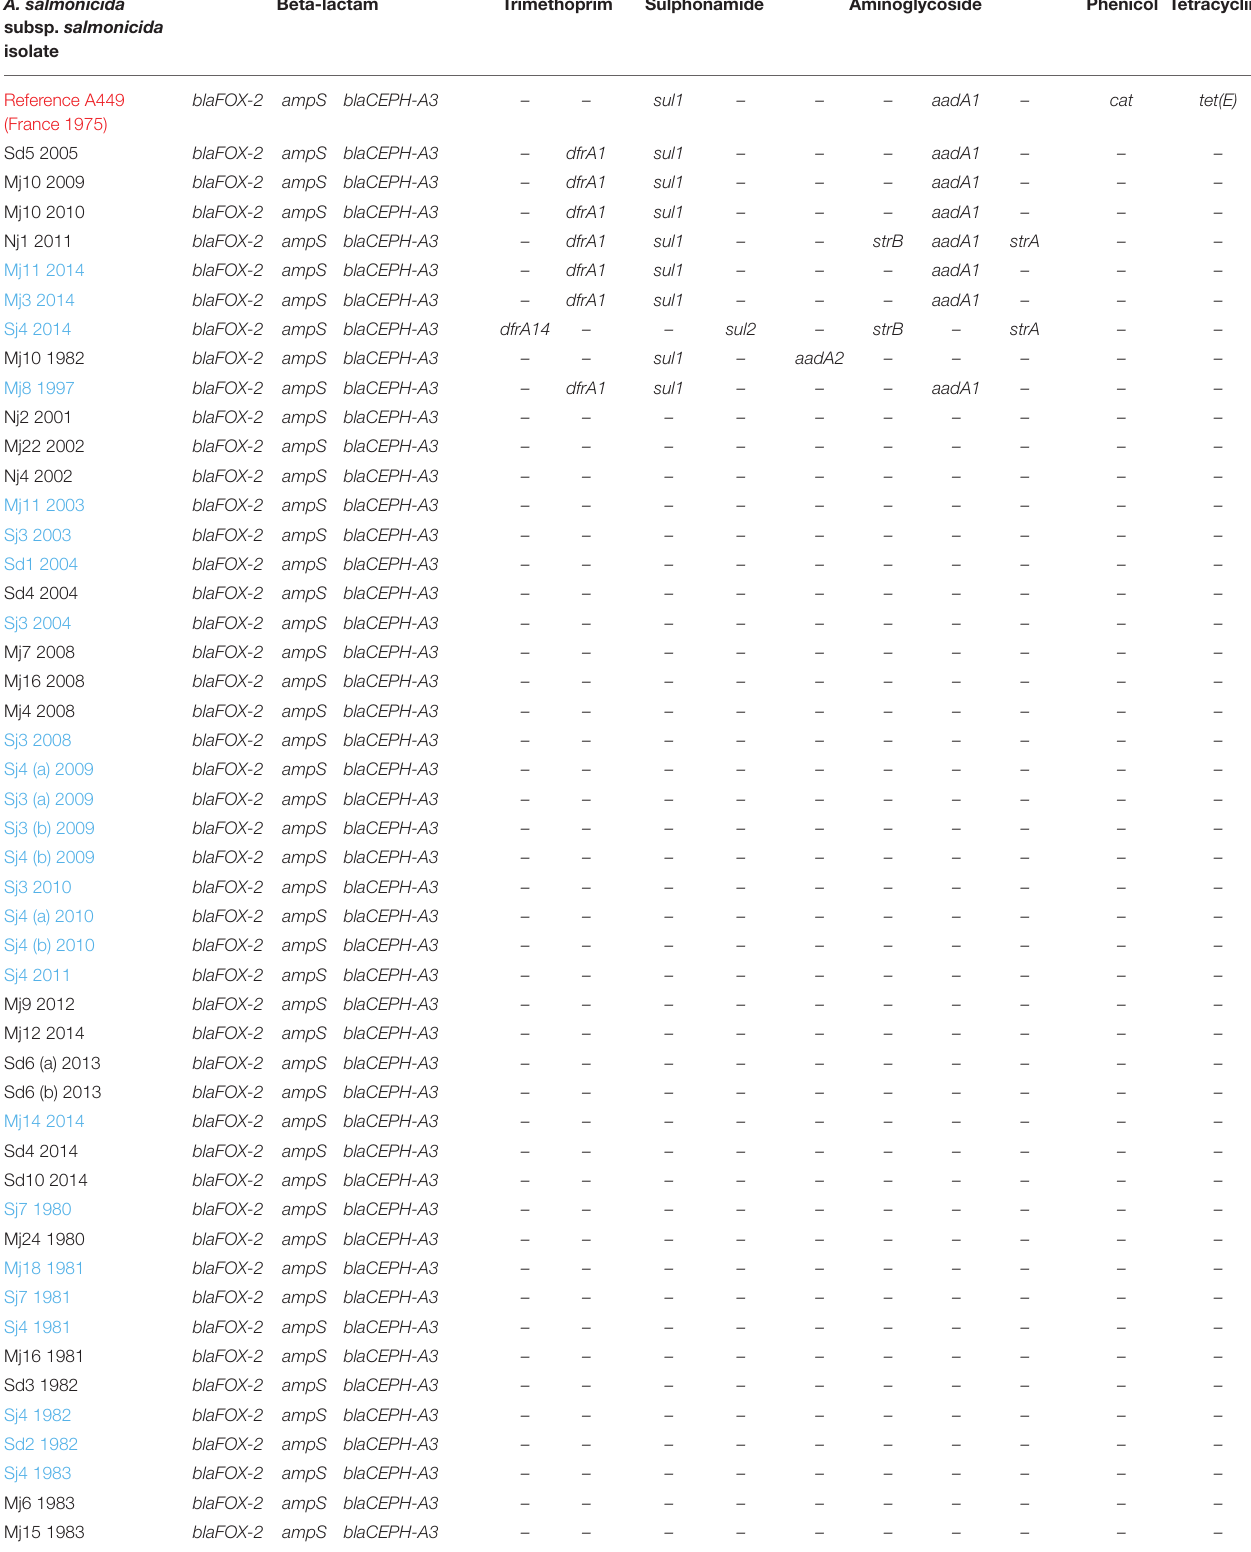
TABLE 1 | Overview of acquired antibiotic resistance genes among the 101 A. salmonicida subsp. salmonicida sequenced isolates and the reference